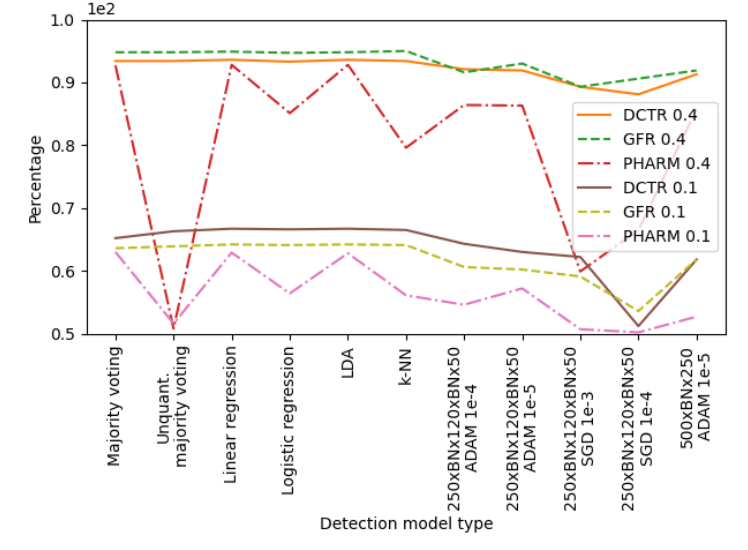
Figure 4. Accuracy achieved for various feature vectors against classifiers or network